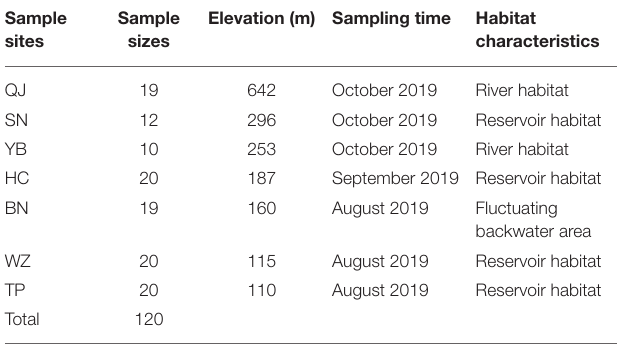
TABLE 1 | Sample information of Saurogobio dabryi